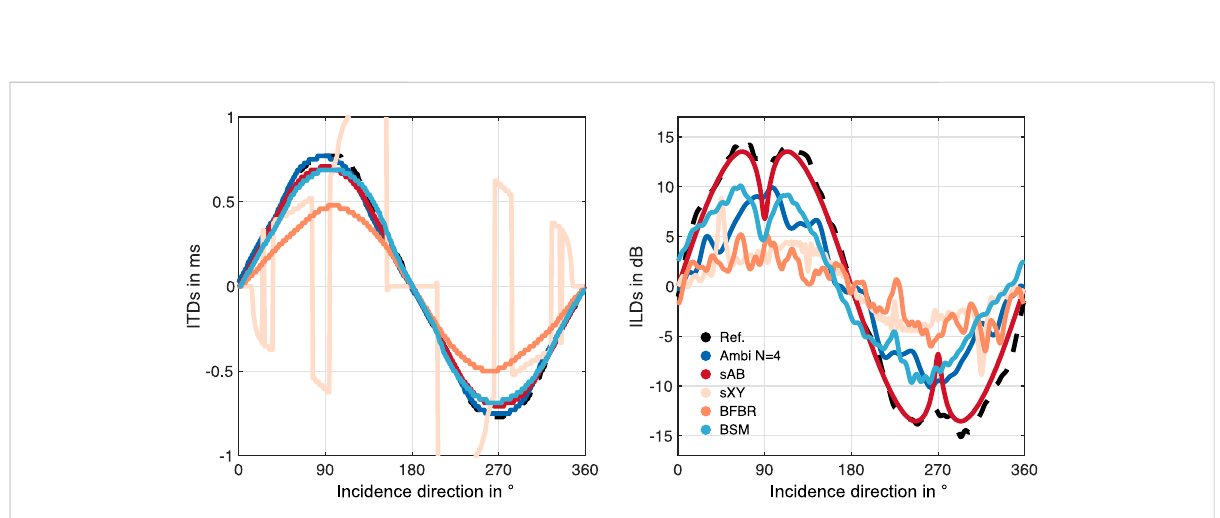
FIGURE 6 ITDs and ILDs of the EMA8 array using different binaural reproduction approaches. The reference values (black dashed lines) were calculated from the KU100 HRTFs.